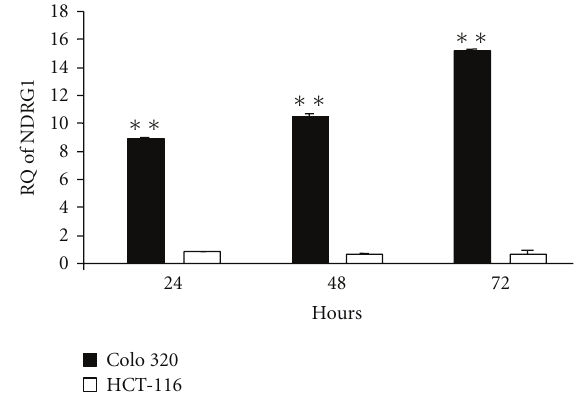
Figure 3: Expression of NDRG1 . Cells treated with 60 μ M DIM for 24, 48 and 72h. The levels of mRNA were examined by real-time PCR and are represented as RQ (relative quantification) = 2 − ddCt . ∗ P value < 0.01, ∗∗ P value < 0.001.